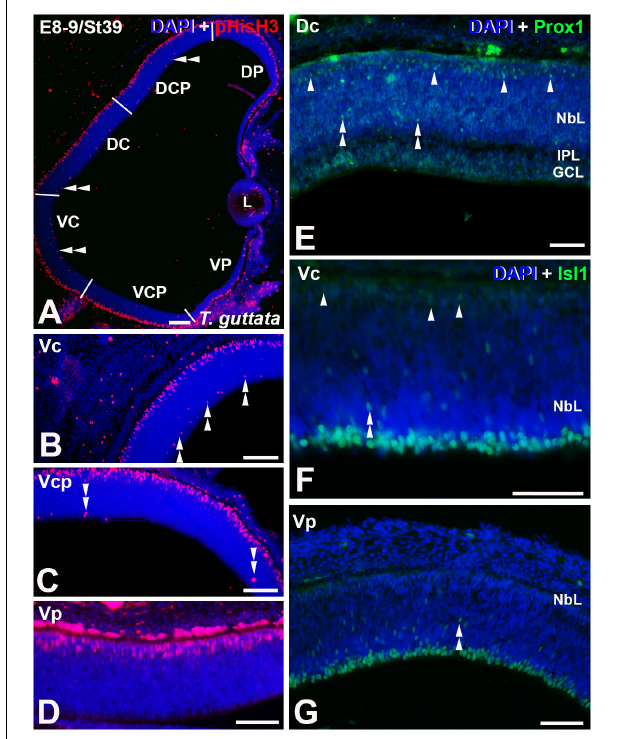
FIGURE 3 | Expression patterns of pHisH3 (A–F) and Prox1 (G) in retinal cryosections of T. guttata at E6 (St30) (A–C) and E7.5-8 (St34) (D–F) . Cryosections were counterstained with DAPI. (A–C) The first non-apical mitosis were detected at E6 in the Dc sector (double arrowheads in A,B). The Dp sector presented an accumulation of pHisH3-immunoreactive mitoses in the apical region of the NbL. (D–G) At E7.5-8, the incidence of pHisH3 positive non-apical mitoses increased in Dc and Dcp sectors [double arrowheads in panels (D–F) ]. (G) Prox1-positive nuclei were detected in close relationship with non-apical mitoses (arrows). Abbreviations: L, lens; NbL, Neuroblastic layer. Scale bars: 100 µ m in panels (A,D) ; 25 µ m in panels (B,C) ; 50 µ m in panels (E–G) .